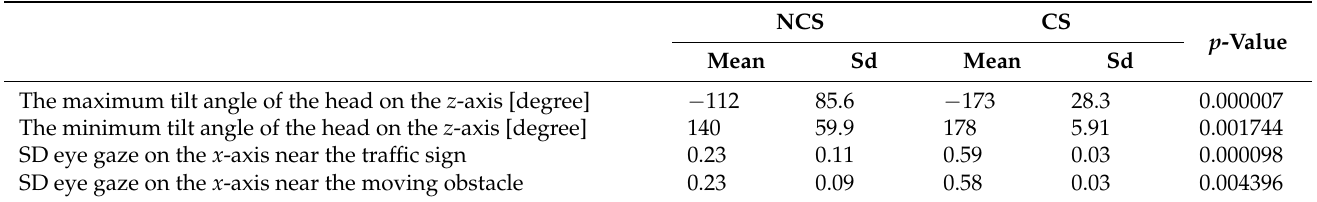
Table 8. Eye-gaze and head characteristics of NCS and CS groups when the subject drove on a public road.